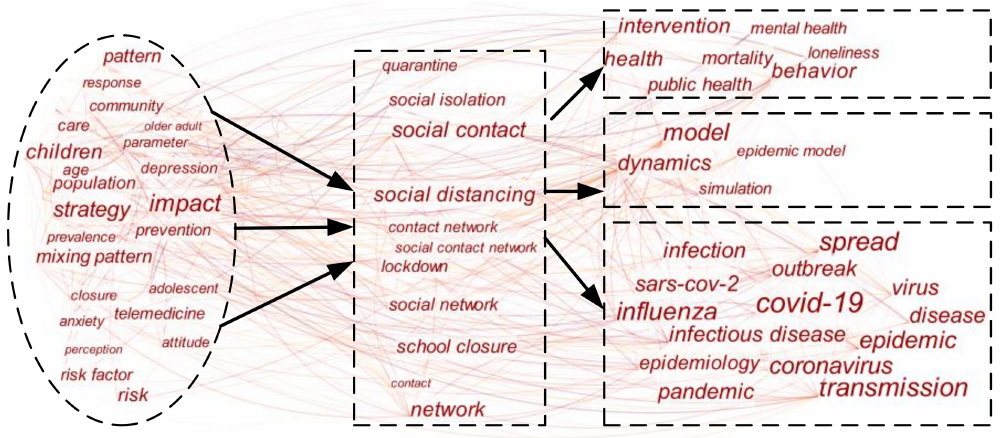
Figure 1. Keywords co-occurrence networks of social distancing